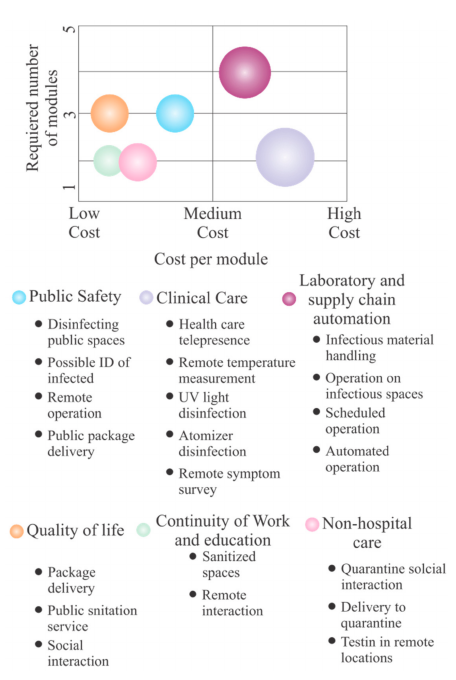
Figure 23. Design and manufacturing